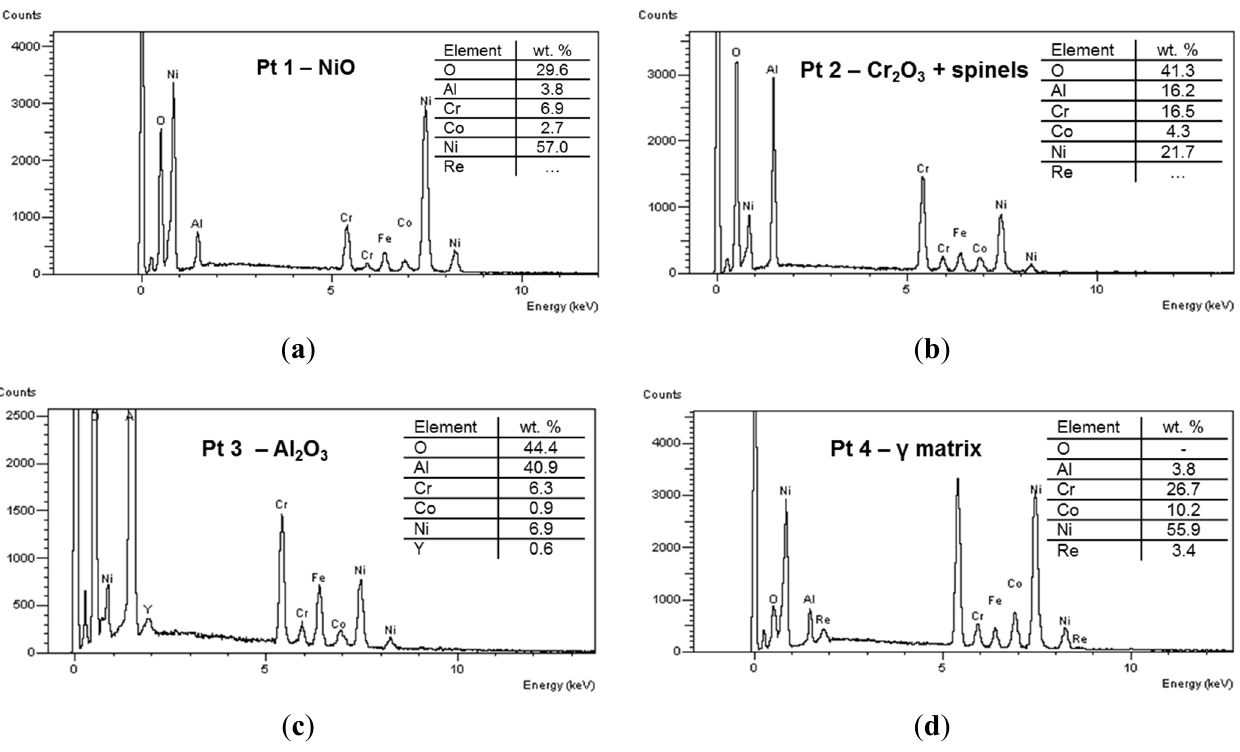
Figure 6. EDS spectra of different spot areas localized in coating microstructure, indicating the presence of ( a ) NiO; ( b ) Cr 2 O 3 + spinels; ( c ) Al 2 O 3 ; and ( d ) γ